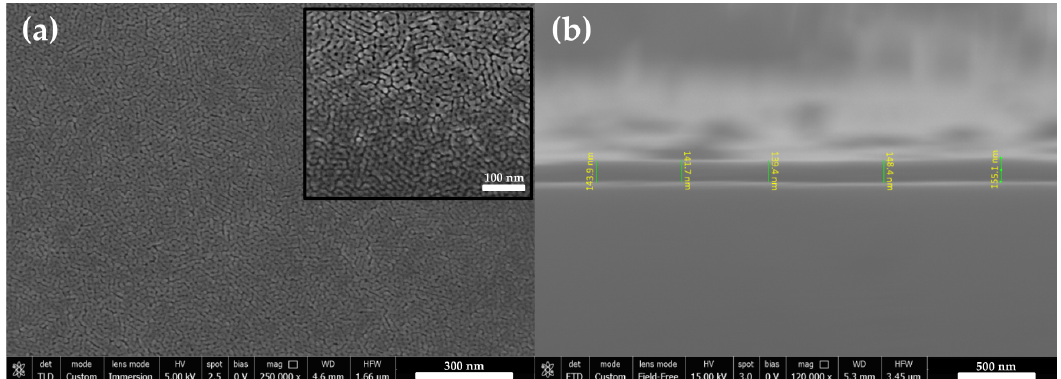
Figure 3. Field-emission (FEG)–SEM micrographs of N–TiO 2 coating: ( a ) microstructure; and ( b ) thickness determination.